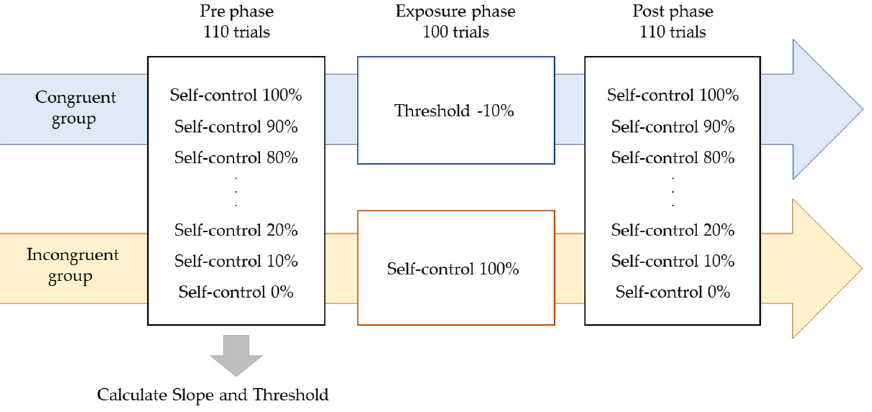
Figure 1. Experimental procedure. The experiment consisted of three phases: the Pre phase, Exposure phase, and Post phase. In the Pre and Post phases for both the Congruent and Incongruent groups, participants performed 10 trials each at 10% intervals, starting at 0% and ending at 100% self-control conditions at random. Participants in the Incongruent group in the exposure phase performed 100 trials of the dot manipulation task at a value 10% lower than the individual’s threshold calculated in the Pre phase. The Congruent group was exposed to 100 trials under the 100% condition.